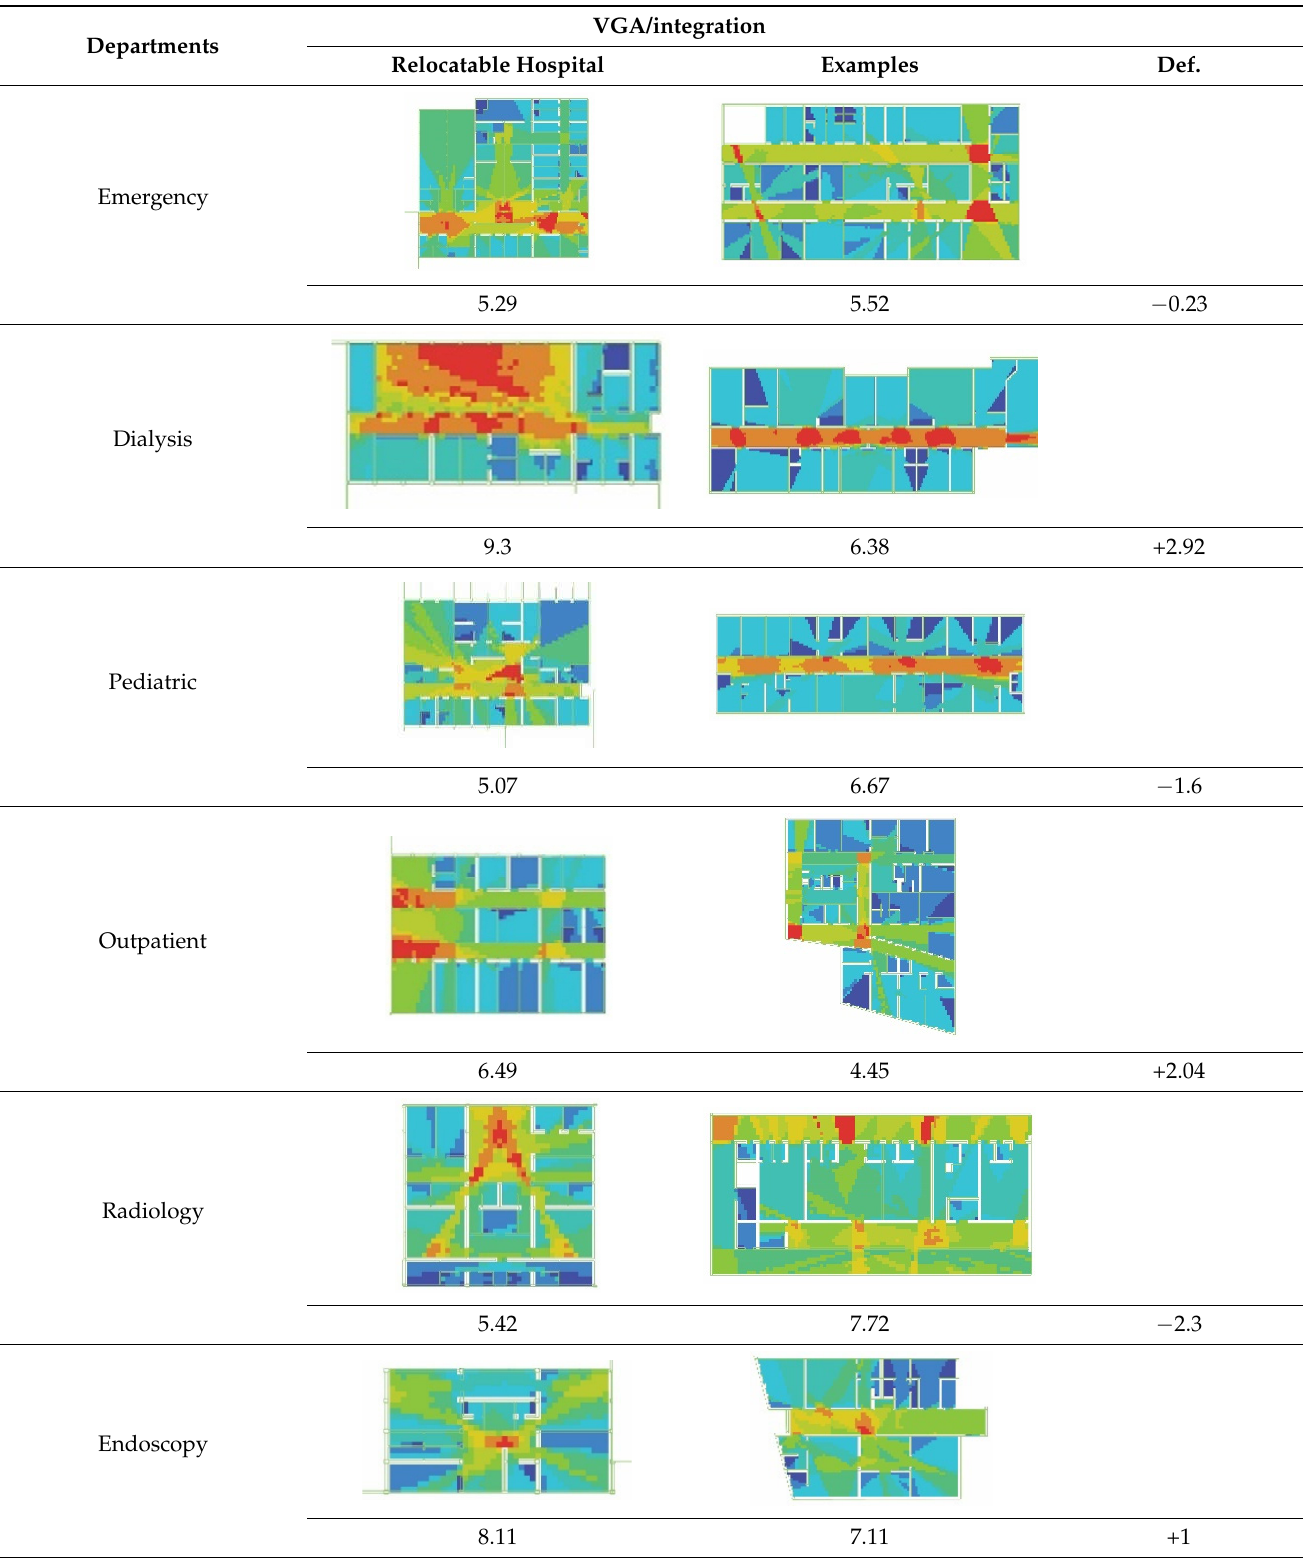
Table 15. Visual graph analysis/integration values and graphs of case study departments compared to examples.